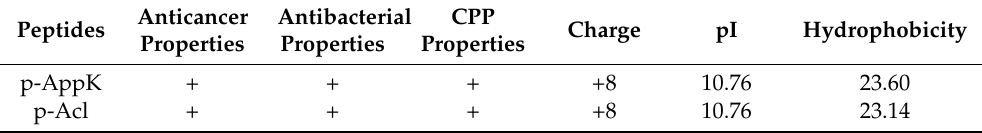
Table 2. Functional predictions and physicochemical parameters of the phospholipase A 2 -derived peptides. In silico tools described in the methodology section were used to predict whether the peptides had (+) or not (-) anticancer, antibacterial, and cell-penetrating peptide (CPP) properties. PepDraw was used to estimate physicochemical parameters (charge, pI, and